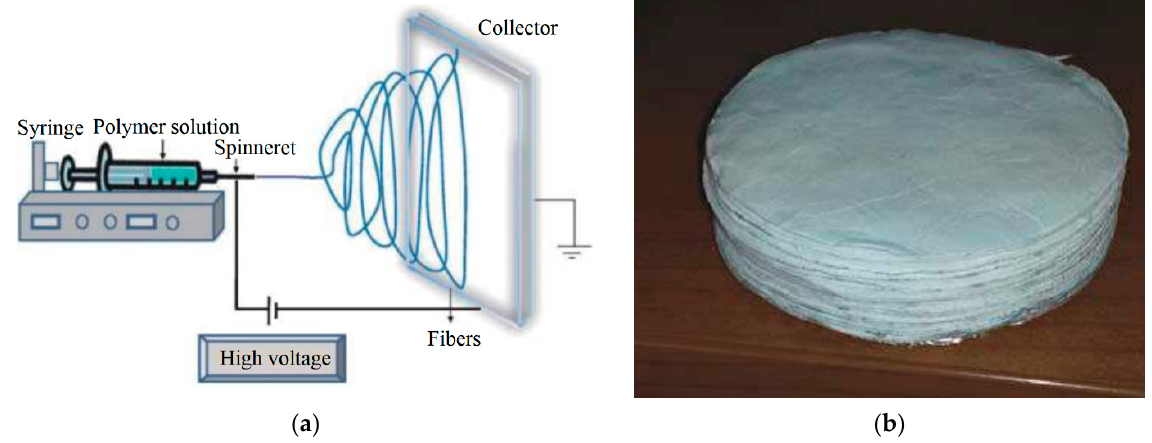
Figure 2. ( a ) Schematic view of the electrospinning process; ( b ) layers of nanofiber textile [19].